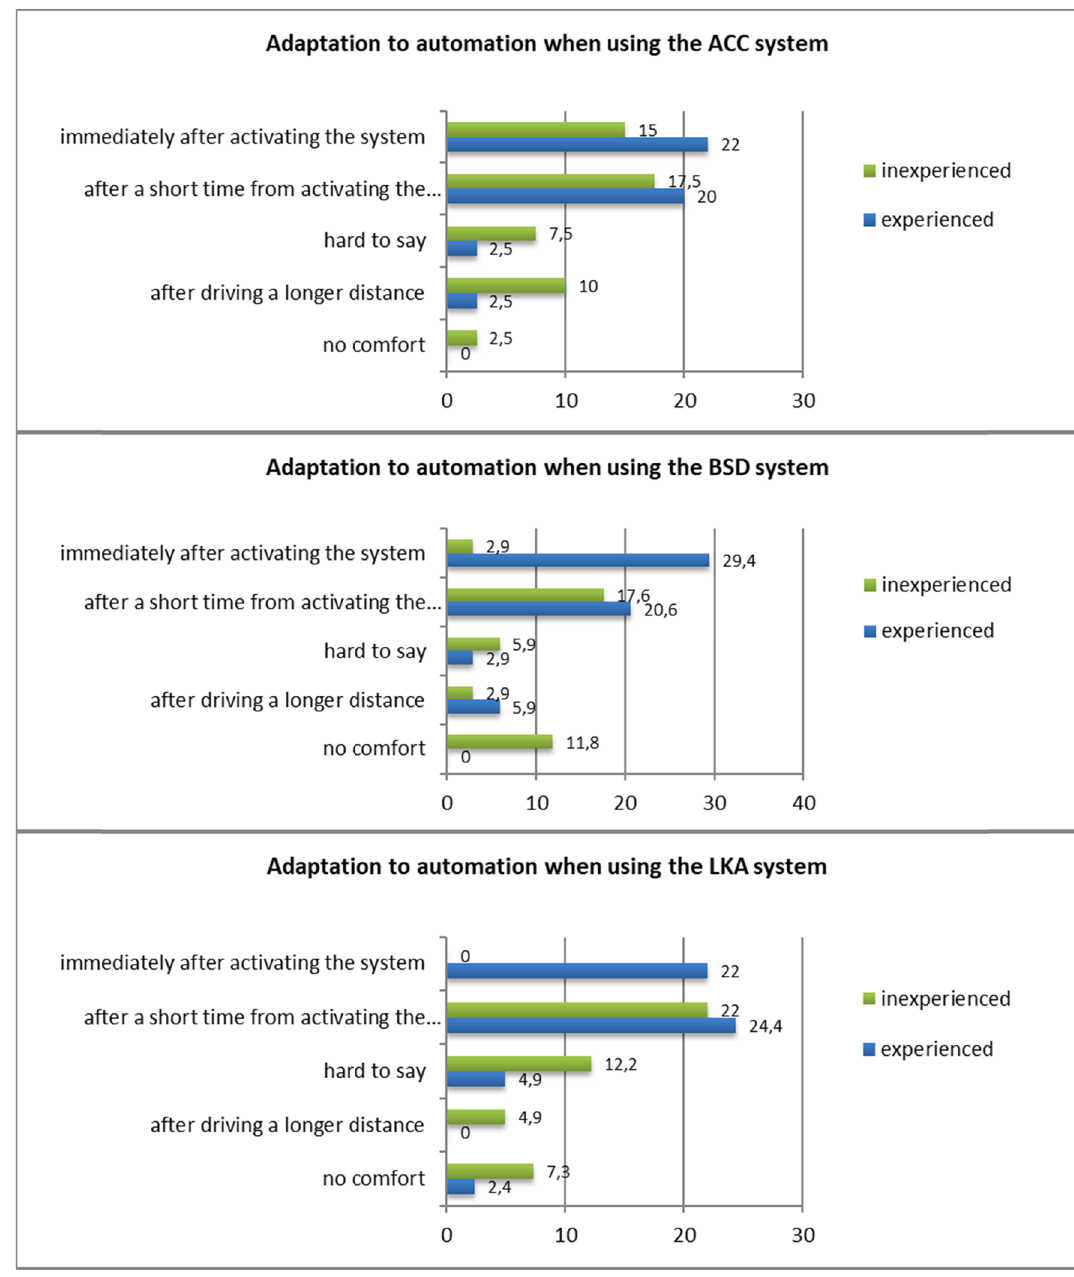
Figure 8: Adaptation to automation when using individual driver - assistance systems in the experienced and inexperienced drivers ( % ) . Source: author ’ s own